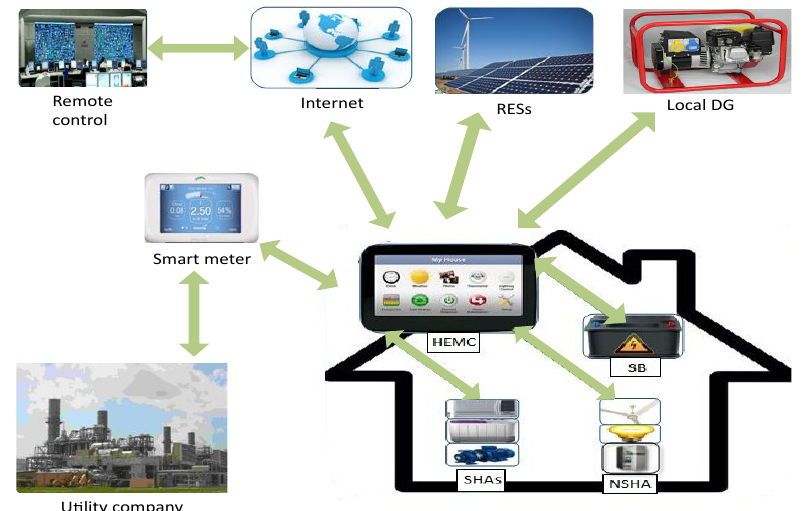
Figure 1. HEMS architecture for a smart home